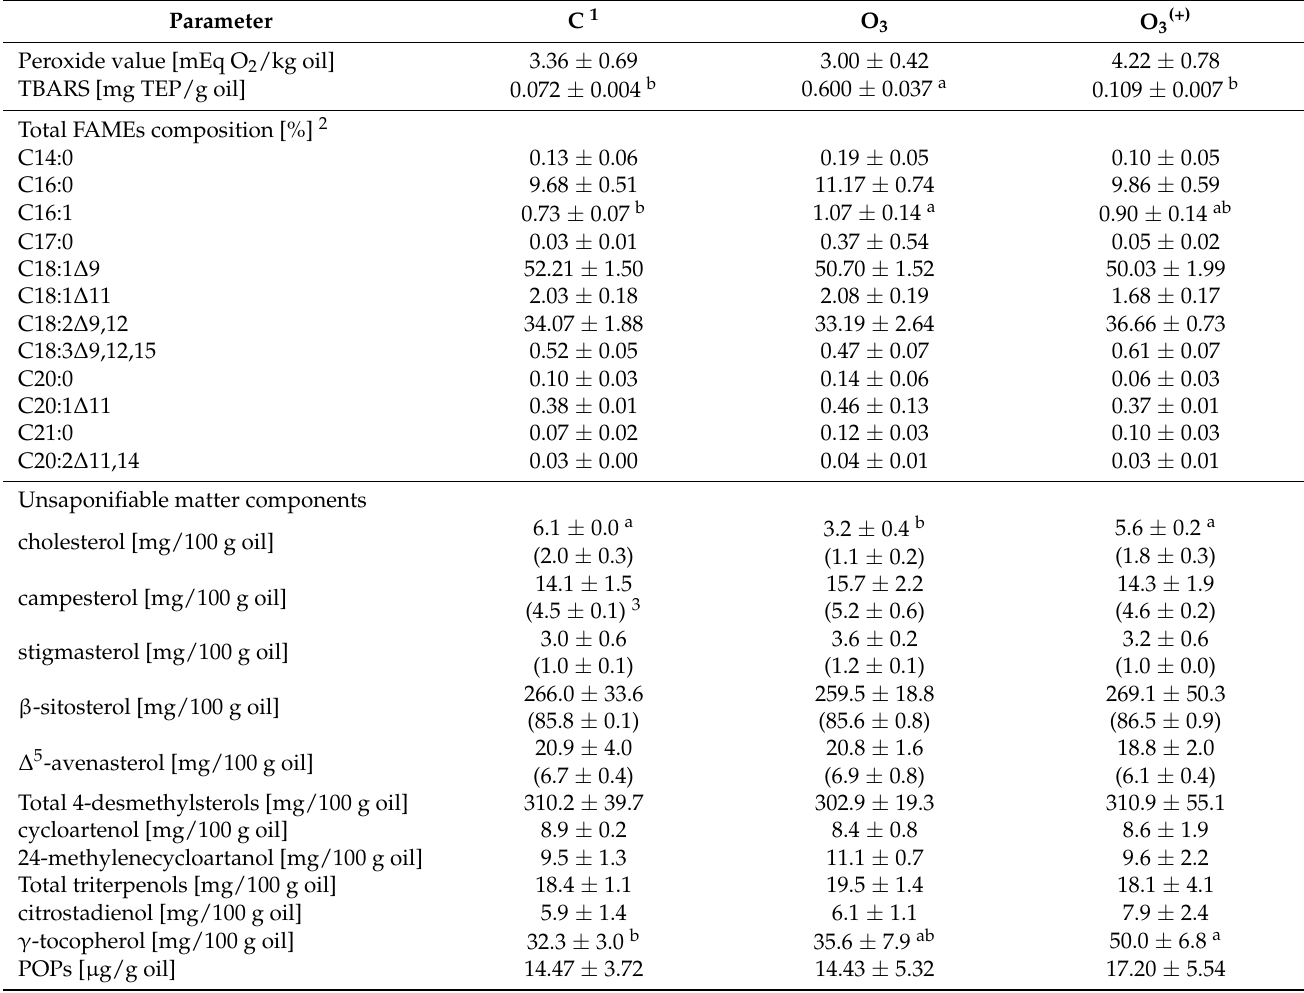
Table 1. Analytical data of pistachio kernel lipids (mean ± SD, n = 3) treated by an SDBD plasma generating